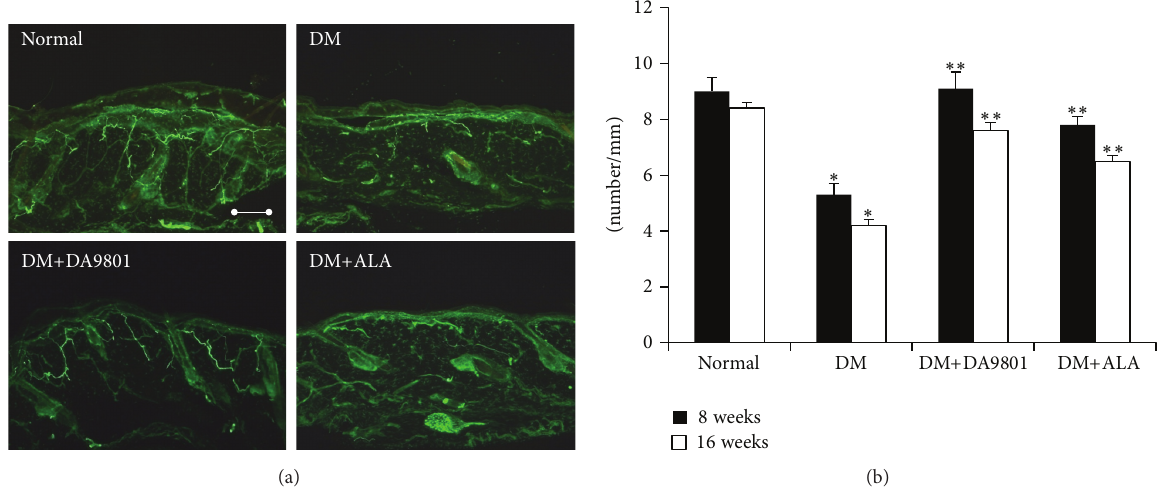
Figure 4: Immunohistochemistry of cutaneous small nerve fibers of the foot dorsum (a) and the IENF density (b) of the experimental groups. PGP 9.5-stained small nerve fibers are more preserved and less shortened, and IENF density was higher in the DM+DA-9801 group than its non-DA-9801-treated DM groups. Data are presented as means ± SD. ∗ 𝑃 < 0.05 versus Normal and ∗∗ 𝑃 < 0.05 versus DM ( 𝑁 = 10 in each group). ALA: Alpha lipoic acid and DM: diabetes. Bar indicates the 100 𝜇 m.